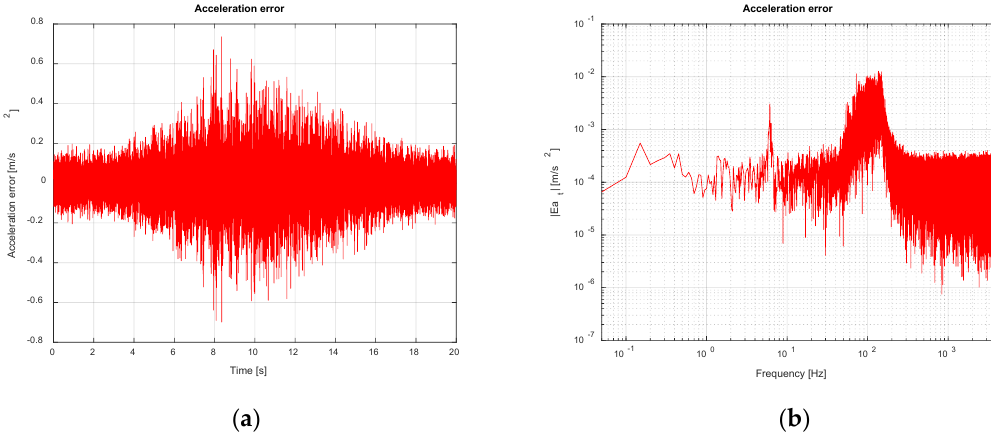
Figure 26. Shake table acceleration error (noise-contaminated scenario). TVC Enabled with improved parameters: ( a ) Time domain; ( b ) Frequency domain.